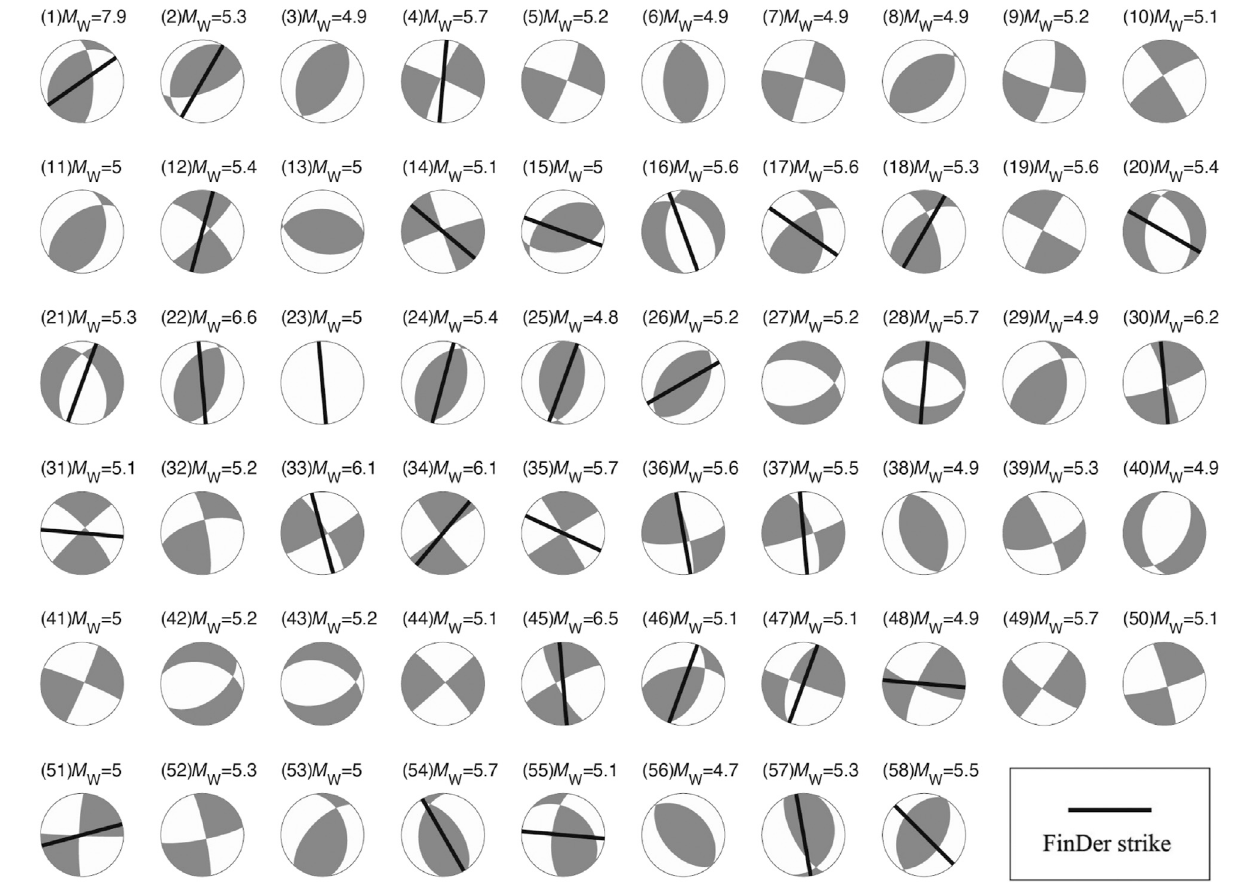
FIGURE 11 | Comparison of the strike of the fi nal FinDer line-source and the GCMT focal mechanism for all 58 earthquakes. The absence of FinDer strike means that FinDer has not been triggered.